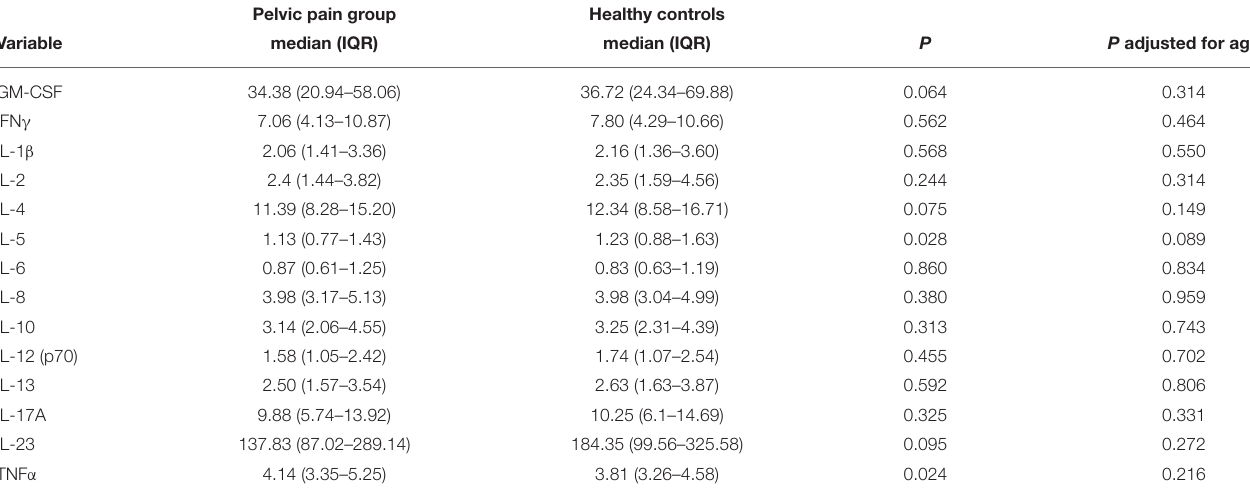
TABLE 1 | Median cytokine levels of the pain group vs. the control group.